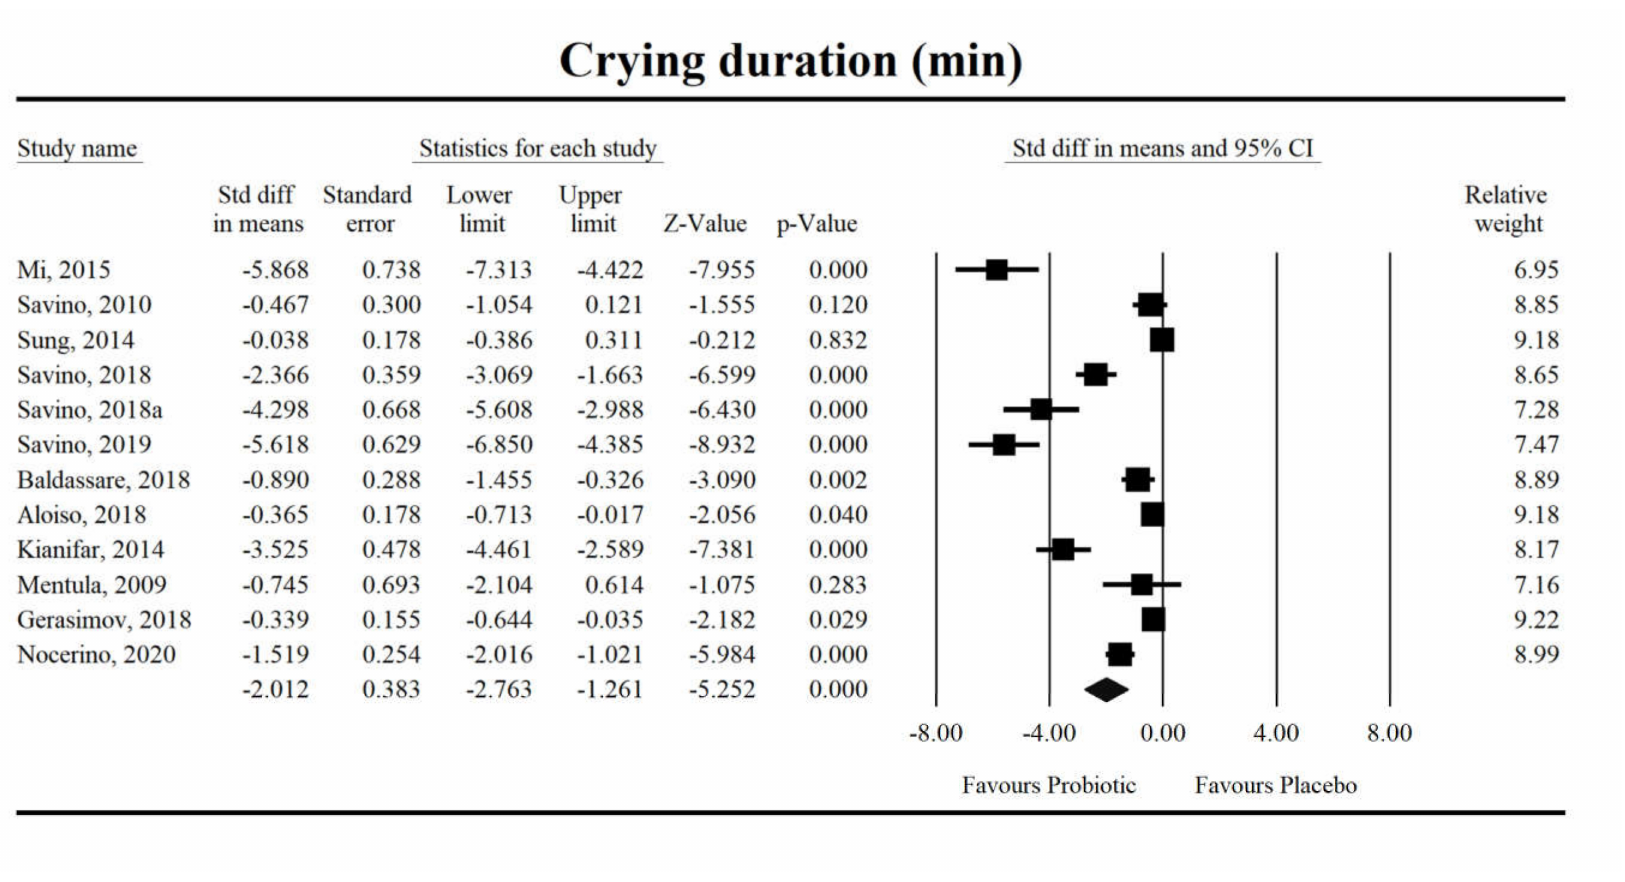
Figure 2. An e ff ect size (random model), standardized mean di ff erence, for crying duration in newborns taking probiotics vs. placebos (controls). Q = 227.3, df(Q) = 11, p < 0.001, I-squared =